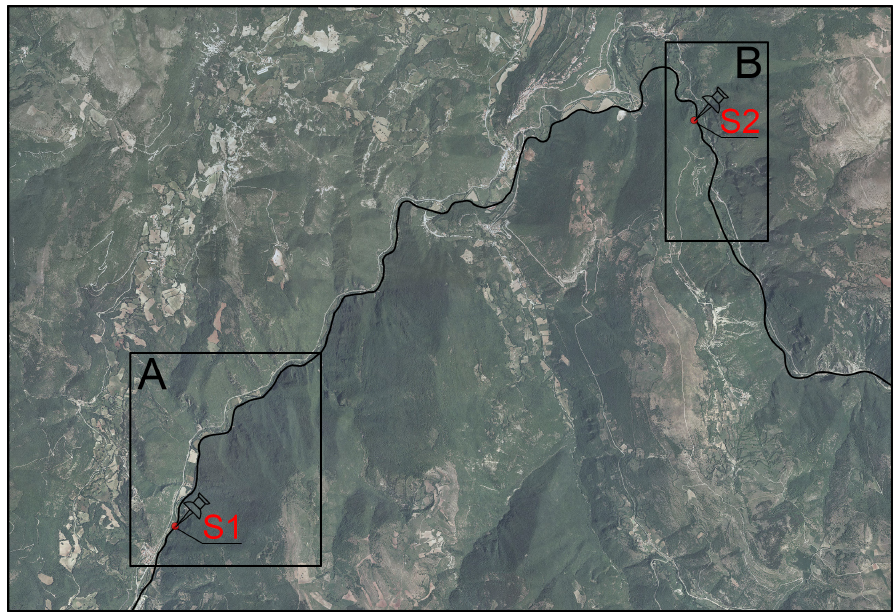
Figure 7. Zoomed view of a portion of the green way Spoleto-Norcia, with the location of the sections S1 and S2 considered for the LEM analyses.